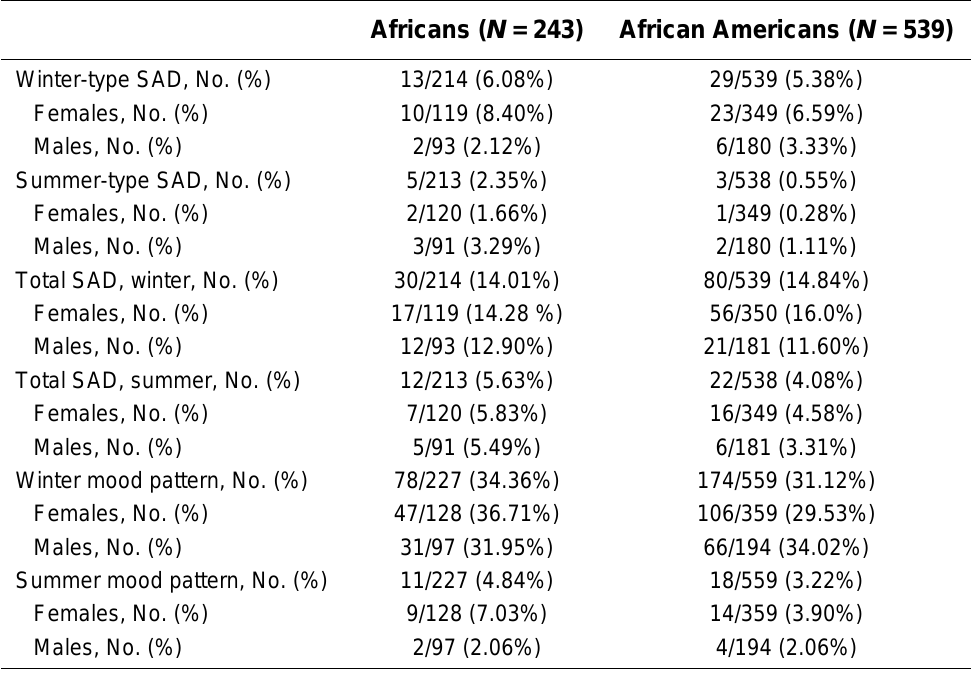
Prevalence Estimates for Winter- and Summer-Type SAD, Total SAD, and Mood Pattern Africans ( N = 243) African Americans ( N = 539) 13/214 (6.08%) 29/539